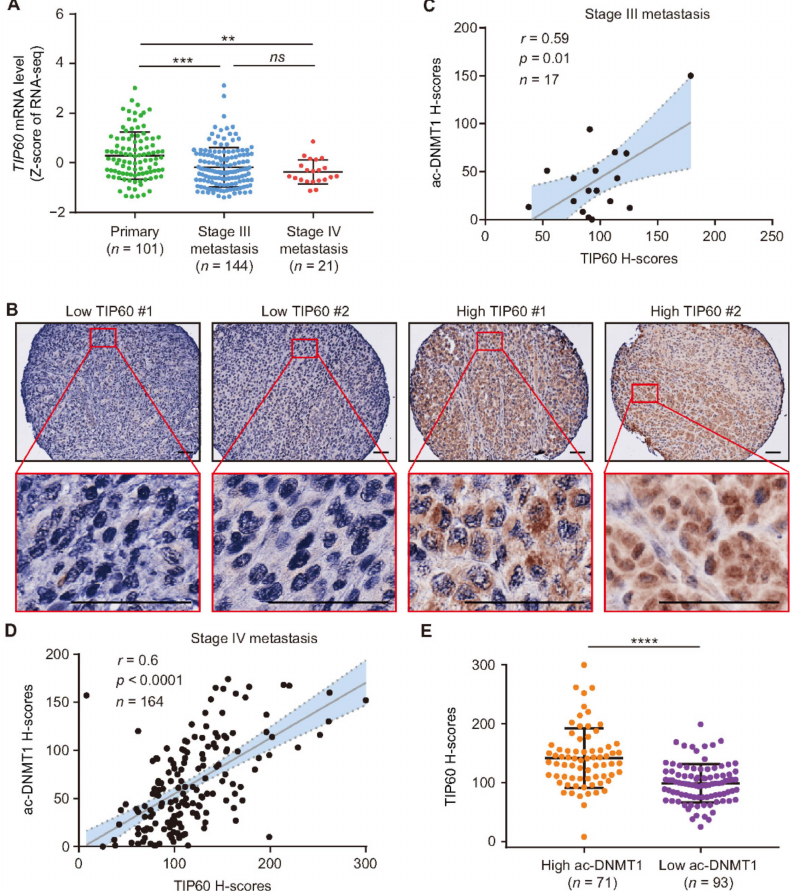
Figure 4. Ac-DNMT1 and TIP60 protein levels positive correlate in metastatic melanoma. ( A ) Comp- arison of TIP60 mRNA expression using TCGA SKCM dataset. ( B ) Representative IHC images of TIP60 in the TMA melanoma cohort. Scale bars = 20 µ m. ( C , D ) Correlation between TIP60 and ac-DNMT1 protein levels in stage III ( C ) and stage IV ( D ) metastatic FFPE tissues. ( E ) Comparison of TIP60 H-scores in stage IV patients with high and low ac-DNMT1 protein levels. The best-fit line (straight line) and the 95% CI (dotted line) are shown in grey. Data represent the mean ± SD. ns : not significant, ** p < 0.01, *** p < 0.001, and **** p <